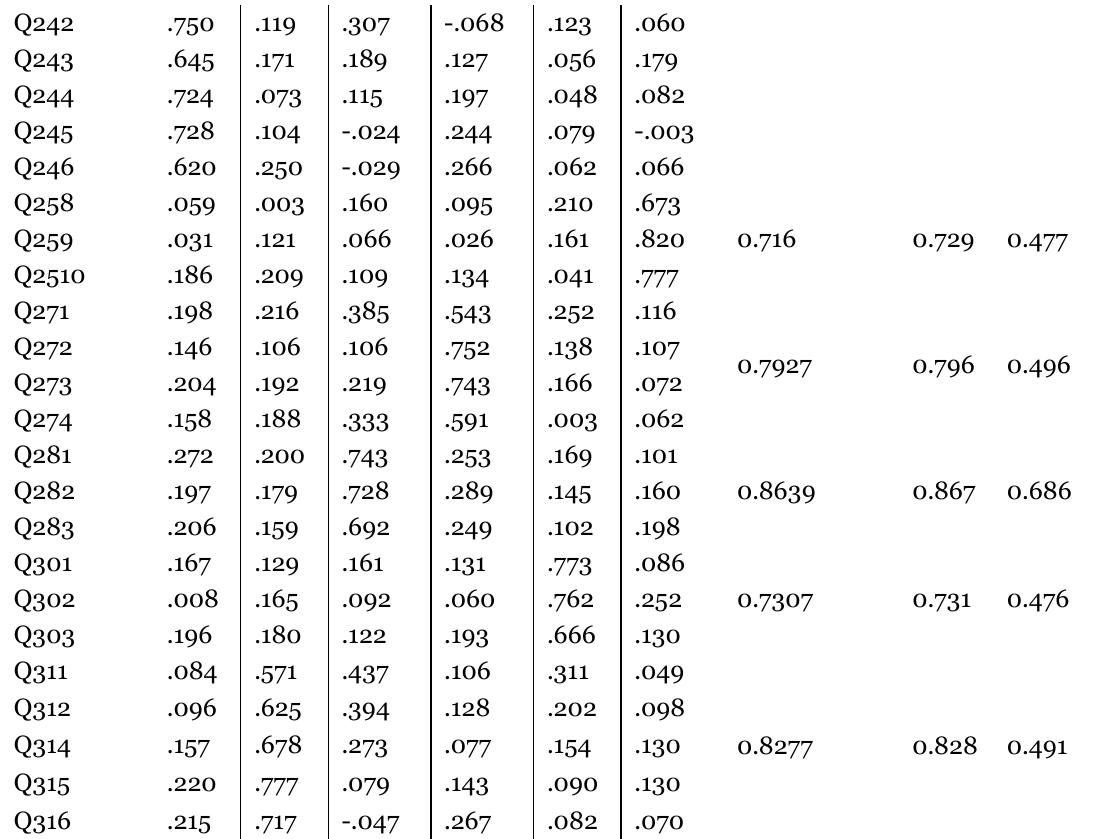
Table 3 Correlation Matrix and Discriminant Assessment Variable Mean Usefulness